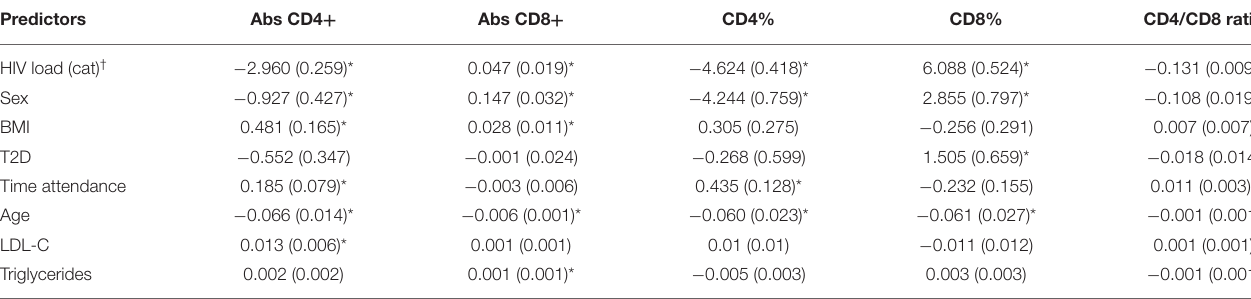
TABLE 2 | Factors associated with laboratory immunological parameters in the VACC ¶ .